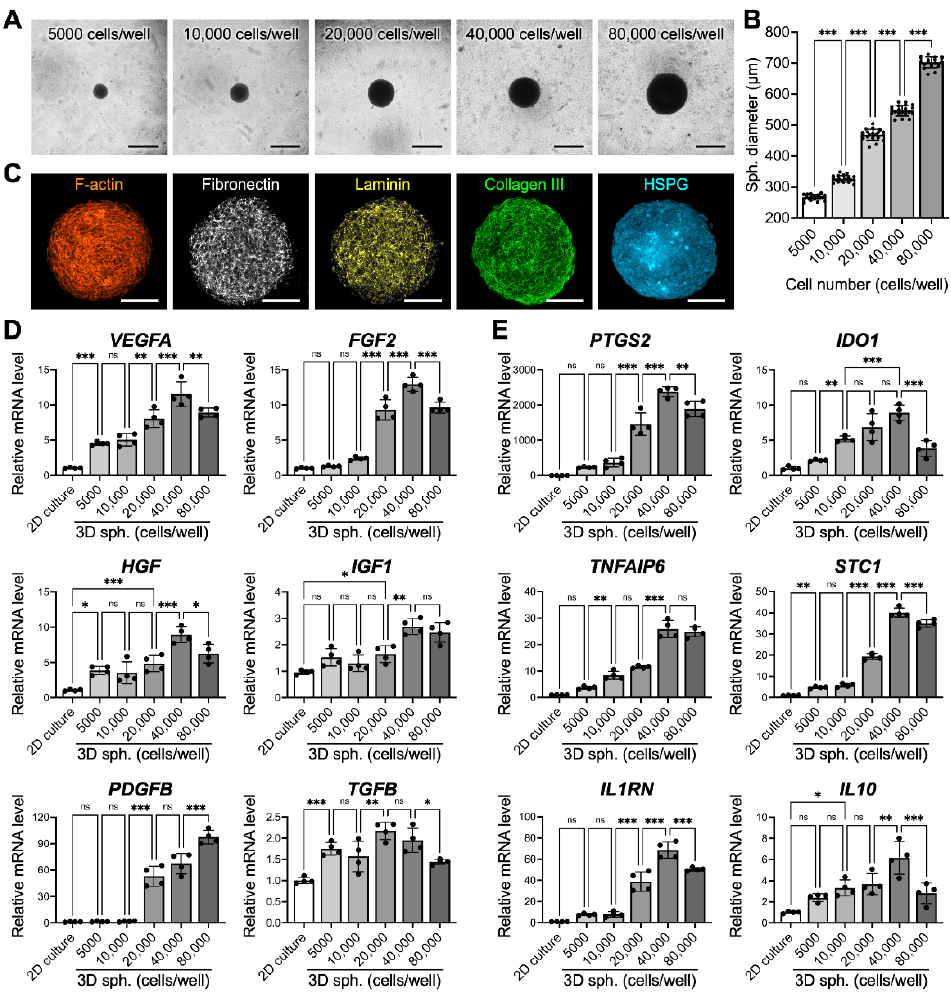
Figure 1. Mesenchymal stem cells (MSCs) assemble into three-dimensional (3D) spheroids (sph.) with precise and controllable sizes and exhibit enhanced therapeutic potential. ( A ) Representative images show the morphologies of 3D MSC spheroids fabricated using various cell seeding densities and ( B ) their corresponding diameters ( n = 21 spheroids pooled from 3 independent experiments, mean ± s.d.) Scale bars, 500 µ m. ( C ) Representative pseudocolored confocal images showing the organization of the cytoskeleton and the presence of extracellular matrix within the formed spheroids. Scale bars, 100 µ m. The mRNA levels of genes that encode pro-regenerative ( D ) paracrine signaling molecules and ( E ) immunomodulatory enzymes/cytokines of MSCs grown with different 3D spheroid sizes or in two-dimensional (2D) monolayered culture are significantly different ( n = 4). * p < 0.05; ** p < 0.01; *** p < 0.001; ns: not significant. HSPG: heparan sulfate